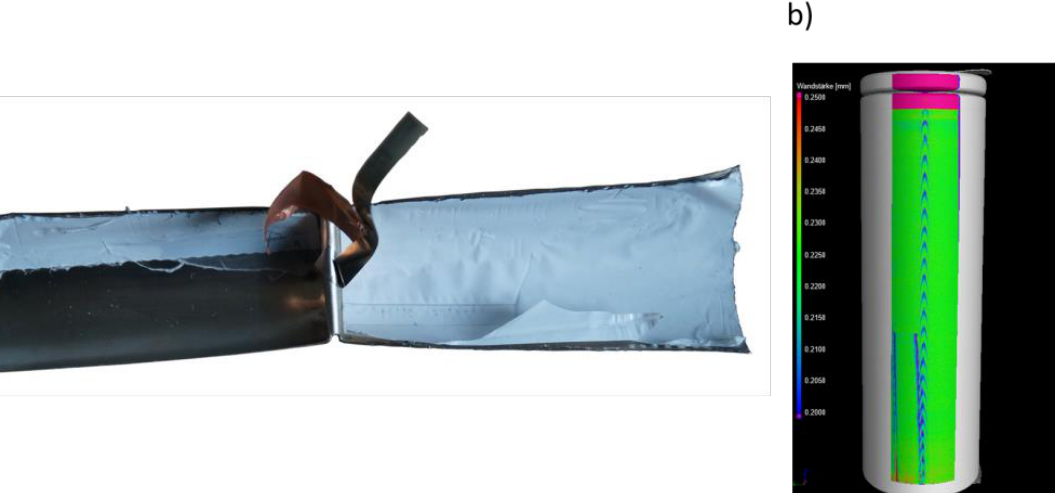
Figure 4. Opened steel casing of the 21700 cell ( a ) and the X-ray scanned casing with optical measured casing thickness distribution over the cell length ( b ).